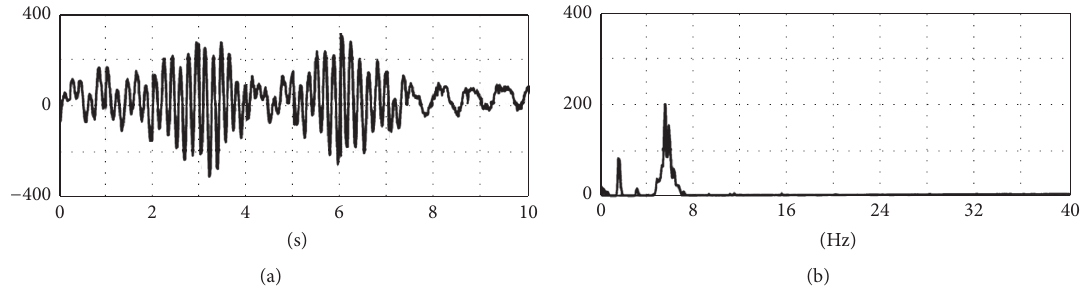
Figure 11: Shaft vibration at the TJB of a LHG with 540 MW, in time (a) and frequency (b) domains (spectrum main peaks are 90 𝜇 mpp@1.5 Hz, 205 𝜇 mpp@5.50 Hz, and 155 𝜇 mpp@5.76